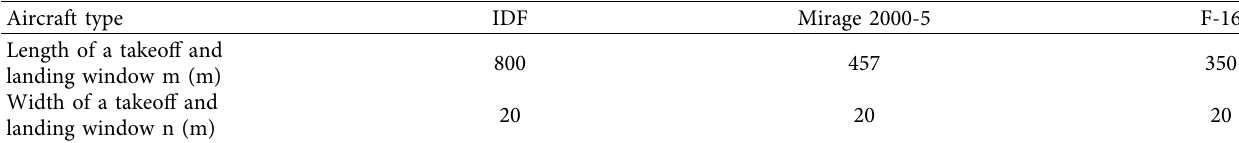
Table 2: Takeoff and landing windows for some